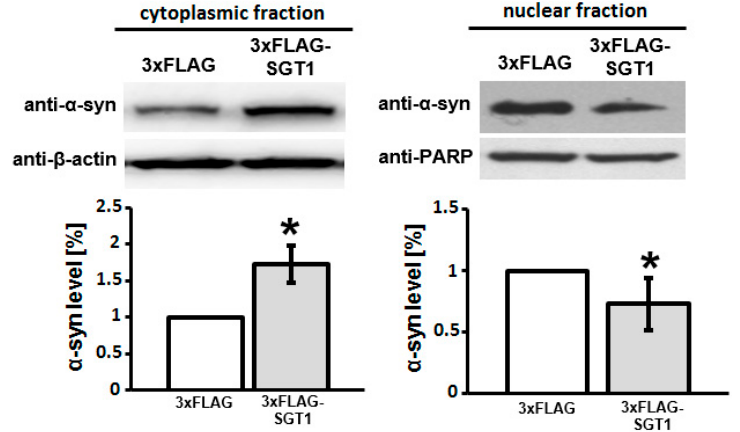
Figure 3. Effect of increased SGT1 level on α -synuclein subcellular localization in HEK293 cells. ( Upper panels ) Representative Western blots showing the level of α -synuclein in cytoplasmic and nuclear fractions obtained from cells overexpressing SGT1 (SGT1-3×FLAG) or control ones (3×FLAG). ( Lower panels ) Statistical analysis of densitometry results obtained from 3 independent experiments. * p ≤ 0.05 .